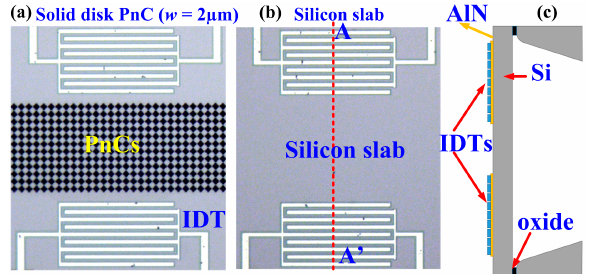
Figure 3. Micrographs of the fabricated delay lines incorporating ( a ) PnCs (with link width of 2 μ m) for the transmission medium and ( b ) solid silicon slab as the transmission medium (as the control device for comparison). ( c ) Transverse-view schematic of the delay line showing that the regions with IDT electrodes are released for both types of delay lines.